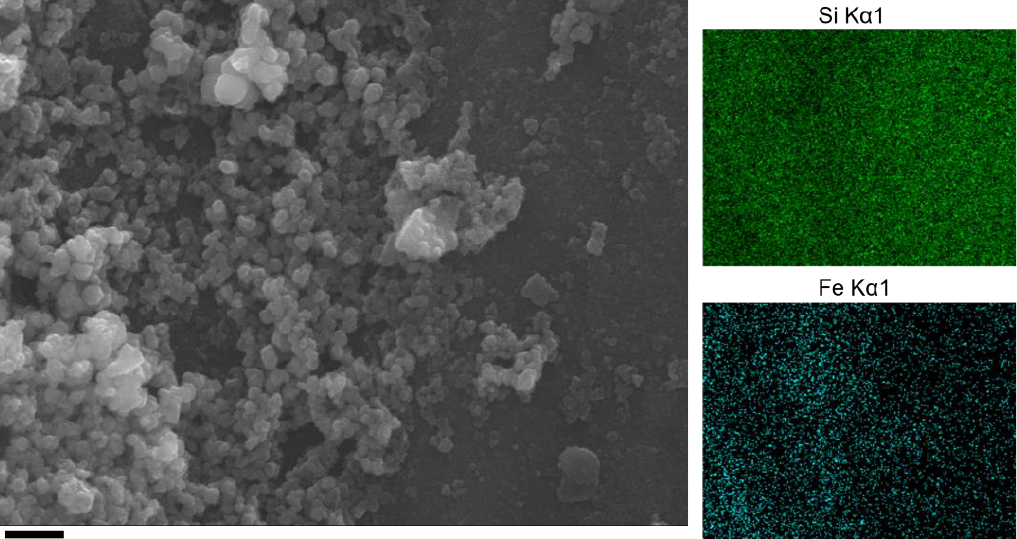
Figure 1. SEM image of GSLP-Fe (D3) (10,000× magnification) and EDS maps. Colored zones indicate the presence of each element: Si (green), Fe (cyan).